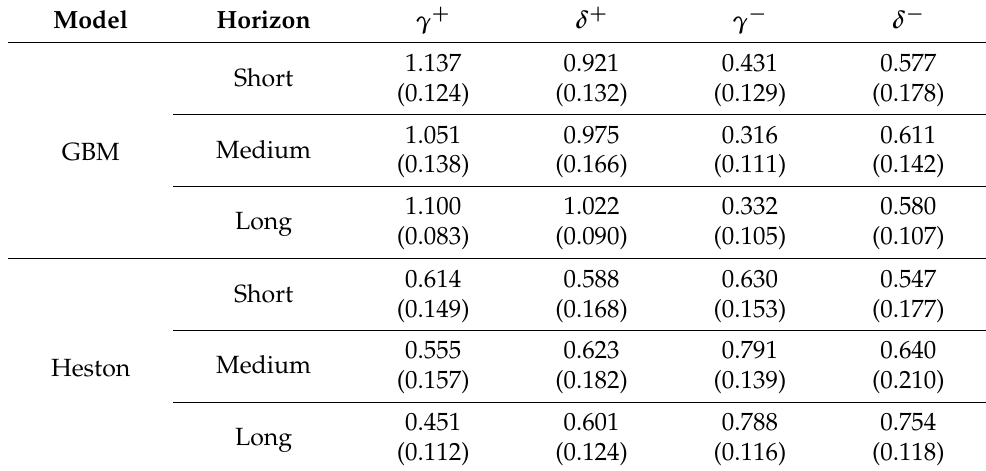
Table 5. The averages of the probability distortion parameter values for different maturity clusters and models, along with their standard deviations in